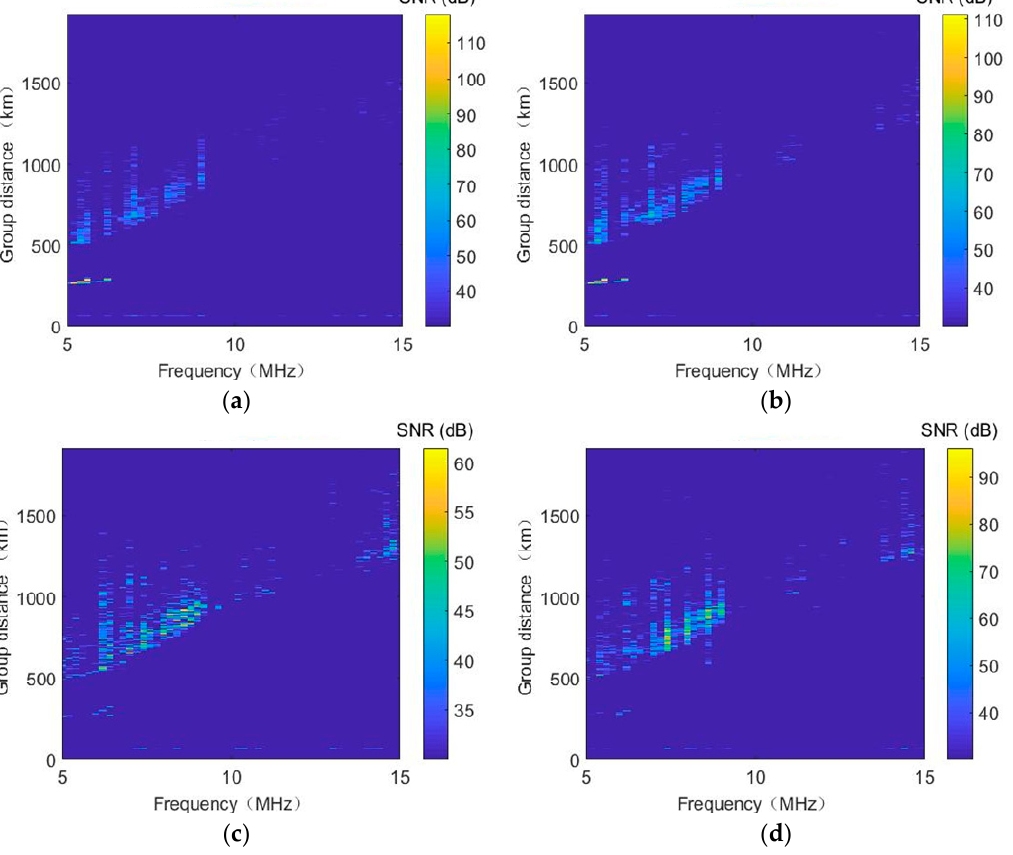
Figure 19. The oblique backscatter ionogram after Constant False-Alarm Rate (CFAR) processing and removal of discrete noise; ( a ) Channel 1; ( b ) DBF; ( c ) SMI; ( d ) ESB.